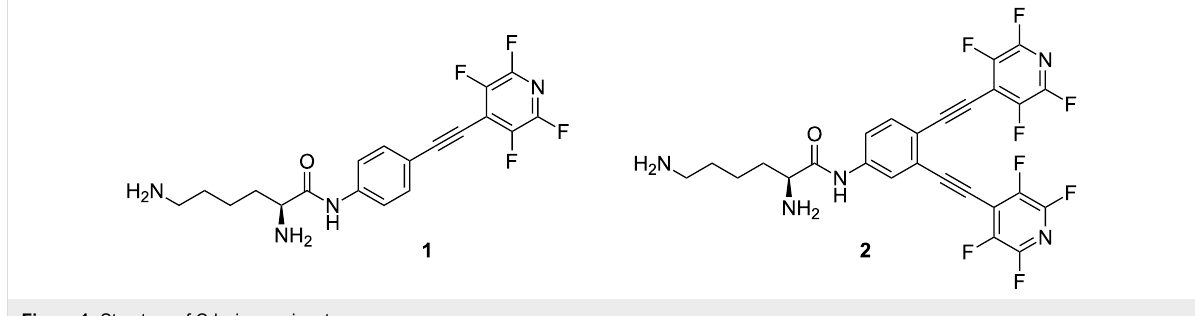
Figure 1: Structure of C-lysine